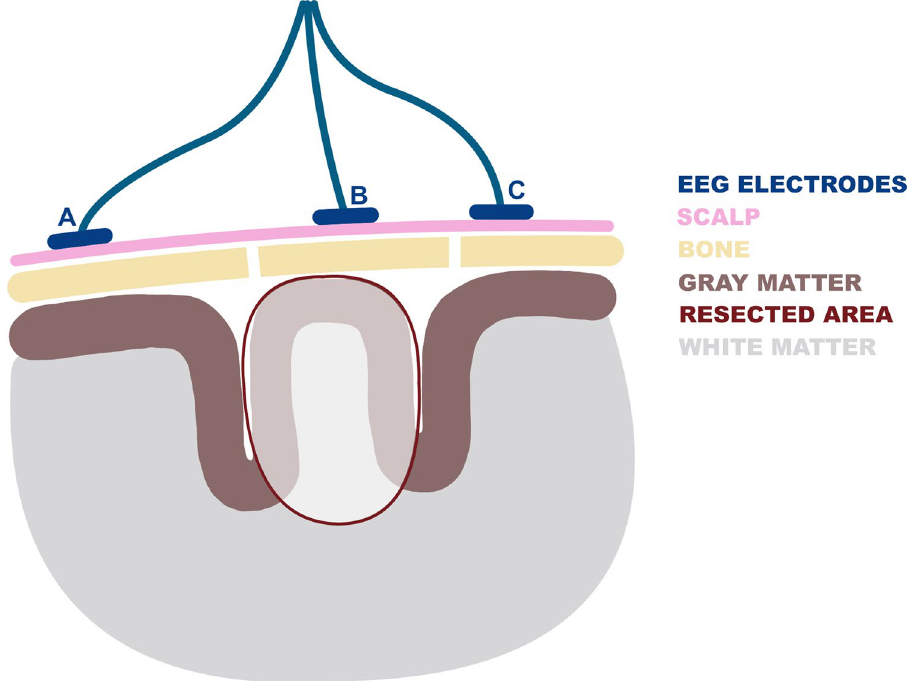
Figure 1. Scalp EEG recording setup following epilepsy surgery. Position of the 10–20 system EEG electrodes following epilepsy surgery in relation to the skull defect resulting from craniotomy and the resected area. For illustrative purposes, we consider that the presurgically defined HFO area overlaps with the resected area depicted here. Electrodes A, B, and C are all located ipsilateral to the craniotomy. Electrode A is located > 1 cm from the skull defect, the HFO area, and the resection area, and thus does not correspond to a channel of interest. Electrode B is located within the HFO area and is thus involved in HFO area channels . Electrode C is located outside the HFO and the resection area but close to the skull defect (≤ 1 cm) and is thus involved in skull defect channels